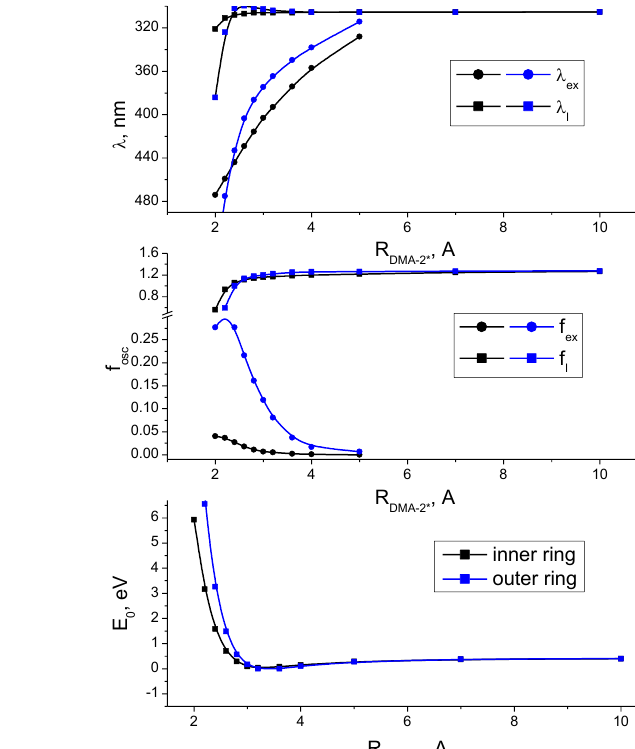
Figure 7. Top to bottom: structures of exciplexes formed by DMA over the outer ring of 1 *, inner ring of 2 * and outer ring of 2 *. The colors of the atoms are as follows: H — cyan, C — gray, N — blue, F — green.